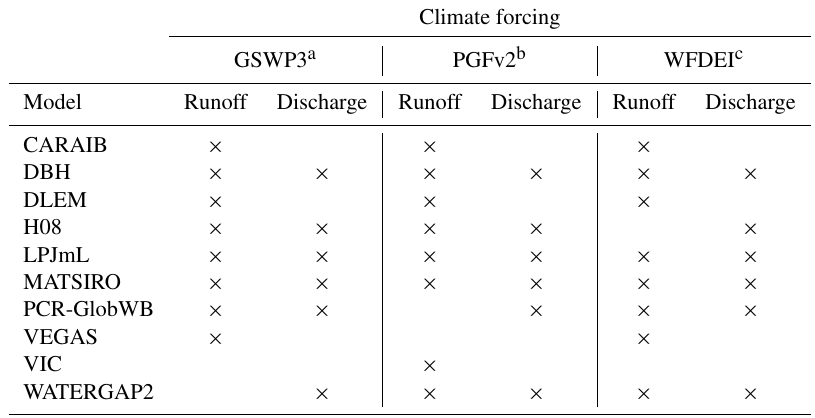
Table 3. ISIMIP 2a total runoff and discharge datasets obtained from the ISIMIP data repository. Climate forcing GSWP3 a PGFv2 b WFDEI c Model Runoff Discharge Runoff Discharge Runoff Discharge CARAIB × ×